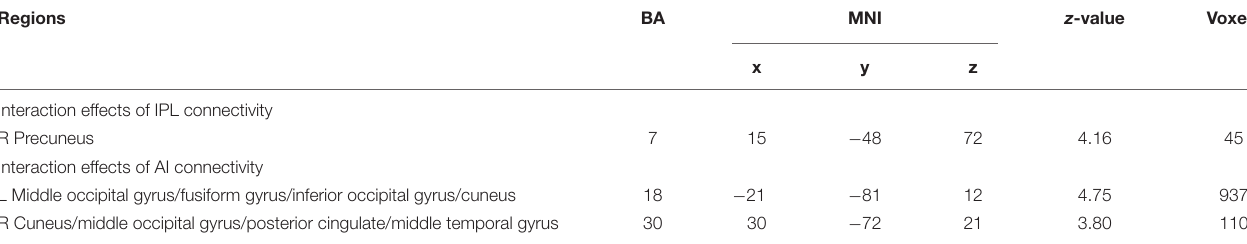
FIGURE 1 | (A) Left insula. (B) Left IPL. Attachment group × Preference condition. Displayed is a rendering of (Attachment group × Preference condition) interaction from the factorial analysis. Bar chart displays the percent signal change in secure attachment group (blue), anxious attachment group (red) and avoidant attachment group (green) for unambiguous, ambiguous and unambiguous vs. ambiguous conditions. Detailed results can be found in Table 5 . The asterisks ( ∗ ) indicate significant differences ( ∗ p ≤ 0.05, ∗∗ p ≤ 0.01, ∗∗∗ p ≤ 0.001). TABLE 6 | Results of the interaction between attachment group and preference condition for left IPL and AI connectivity.